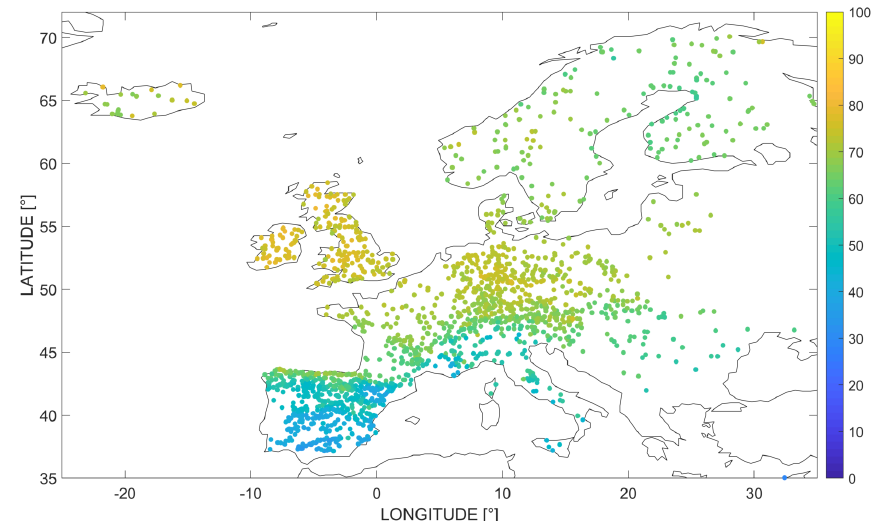
Figure 4. Annual percentage of clouds for the 1957 selected stations according the cloud dataset by Wilson and Jetz